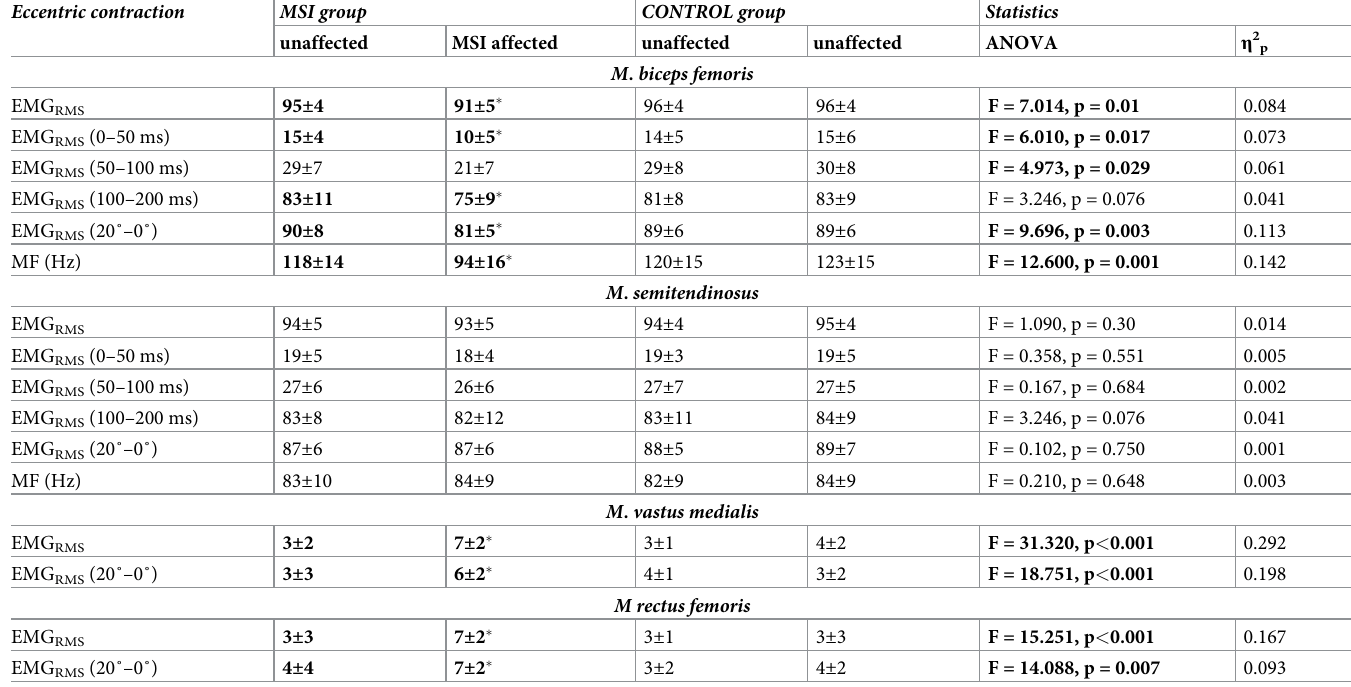
Table 2. Neuromuscular